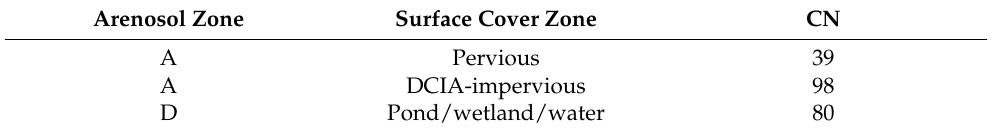
Table 7. Curve number (CN) dataset.